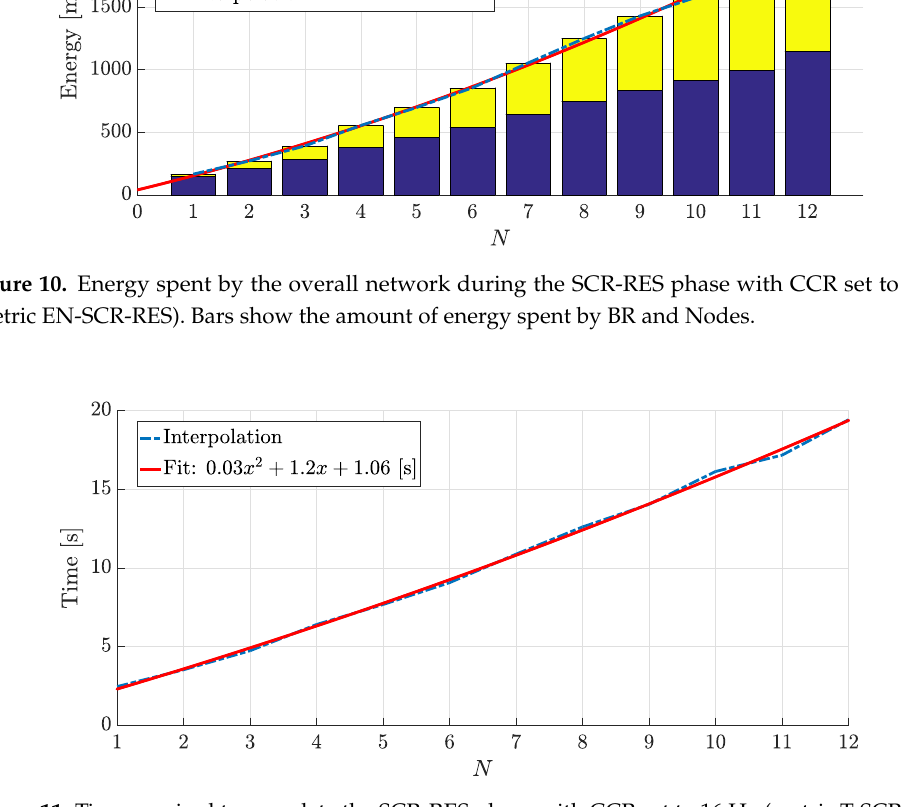
Figure 11. Time required to complete the SCR-RES phase with CCR set to 16 Hz (metric